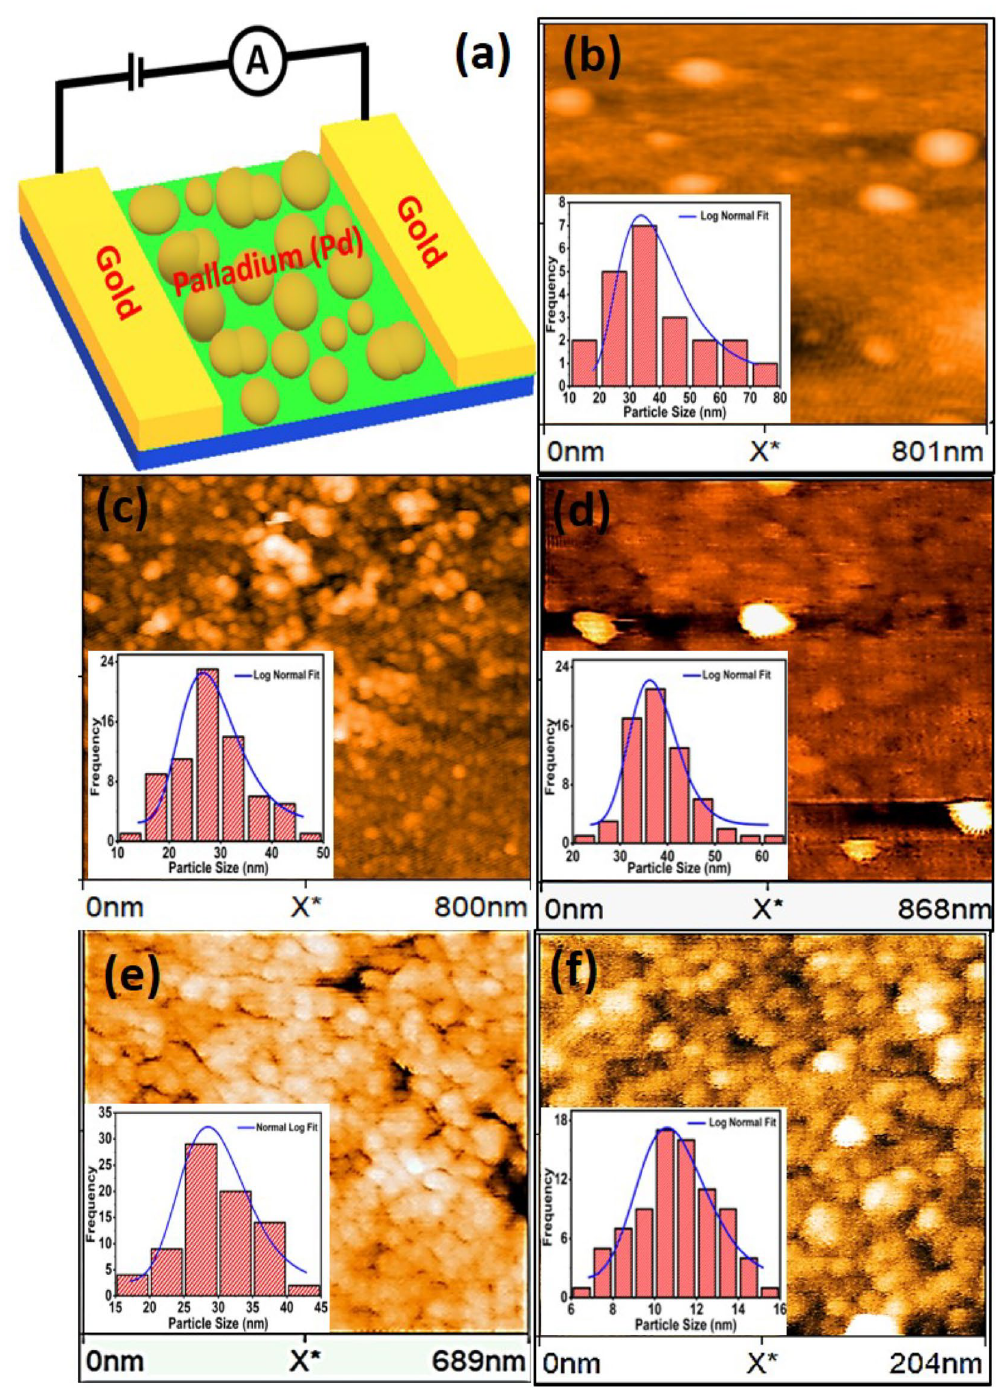
Figure 3. ( a ) represents a schematic diagram of contact geometry for measuring resistance in island-like ultra- thin Pd film. Blue colour depicts the glass substrate while green denotes a SAM deposited on top of glass. AFM topographs of ultra-thin films grown with ( b ) 3 nm, ( c ) 4 nm, ( d ) 4.5 nm, ( e ) 4.75 nm and ( f ) 5 nm thickness. Inset of each shows a log-normal distribution of grains obtained using the Image J